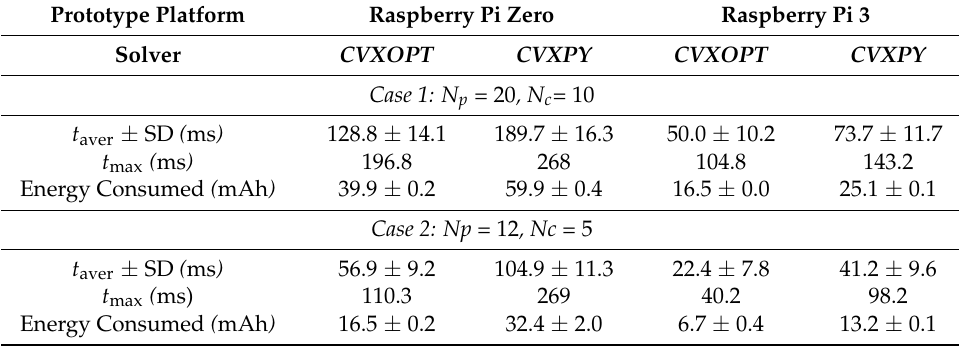
Table 4. Solver runtime performance computed for 4000 time points; t ave r , t max and SD are the average, the maximum and the standard deviation of the solver runtime in ms observed over the duration of the experiment; the average and the standard deviation of the total energy in mAh consumed over the duration of the experiment are reported for both